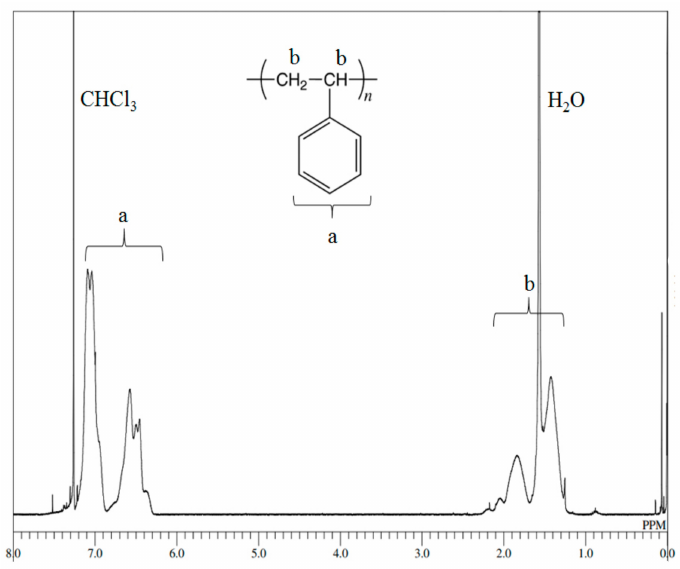
Figure 5. 1 H-NMR spectrum of solubilized fraction of composite particles for run 4 in CDCl 3